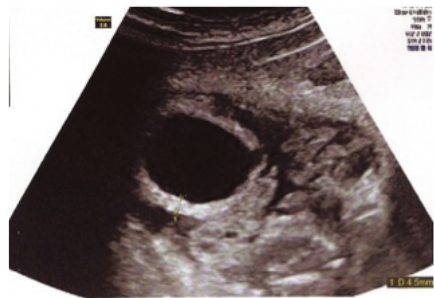
Figure 1: Rupture of detrusor and hypertrophic bladder.